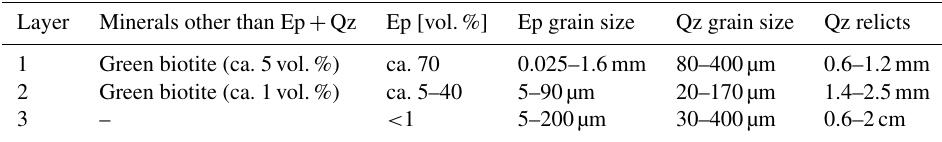
Table 1. Main characteristics of the vein layers. Ep: epidote; Qz: quartz; vol.: volume. Layer Minerals other than Ep + Qz Ep [vol.%] Ep grain size Qz grain size Qz relicts Green biotite (ca. 5vol.%) Green biotite (ca.